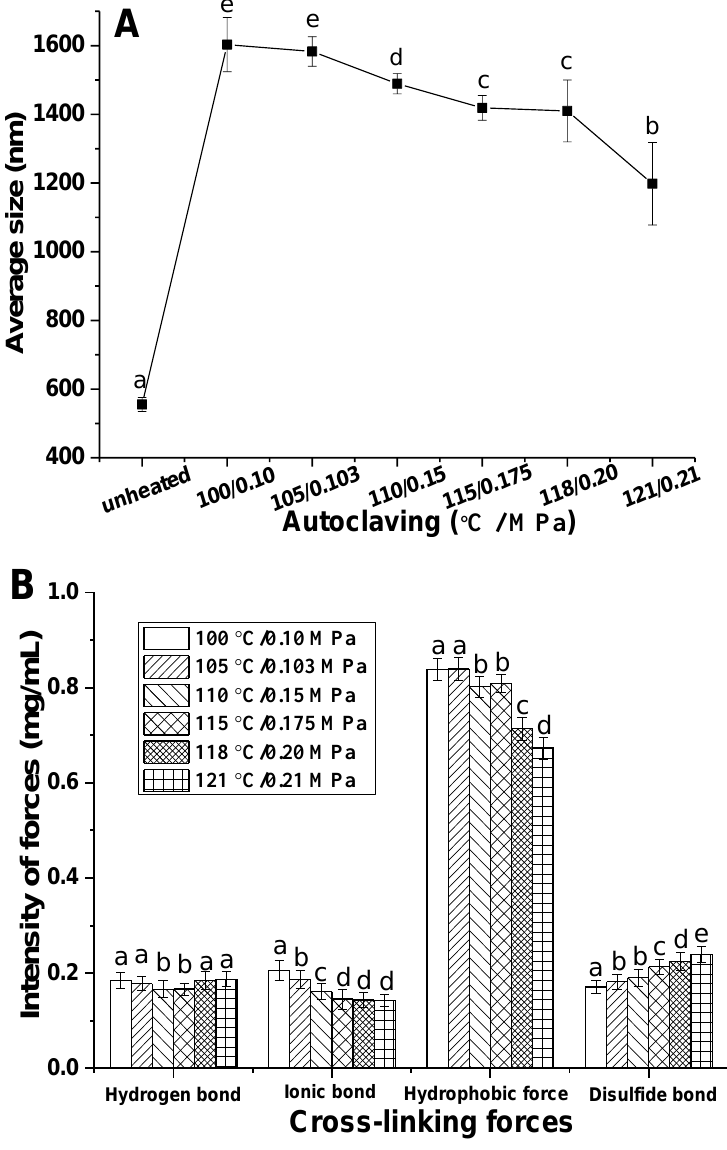
Figure 3. ( A ) Average size of aggregates in CMP solutions after various autoclaving; ( B ) Cross-linking forces in various CMP gel. Bars indicate the standard deviations of the means ( n = 3), and different lowercase letters (a–e) on the top of the columns represent significant difference in the same cross-linking force between CMP gels obtained at various autoclaving according to Duncan tests ( p < 0.05).